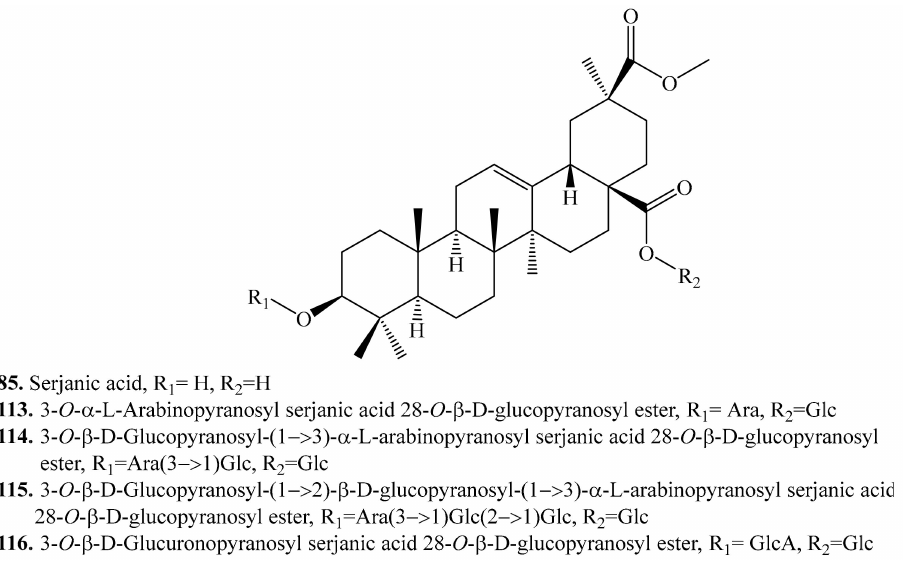
Figure 14. Structures of serjanic acid and its glycosides isolated from quinoa.